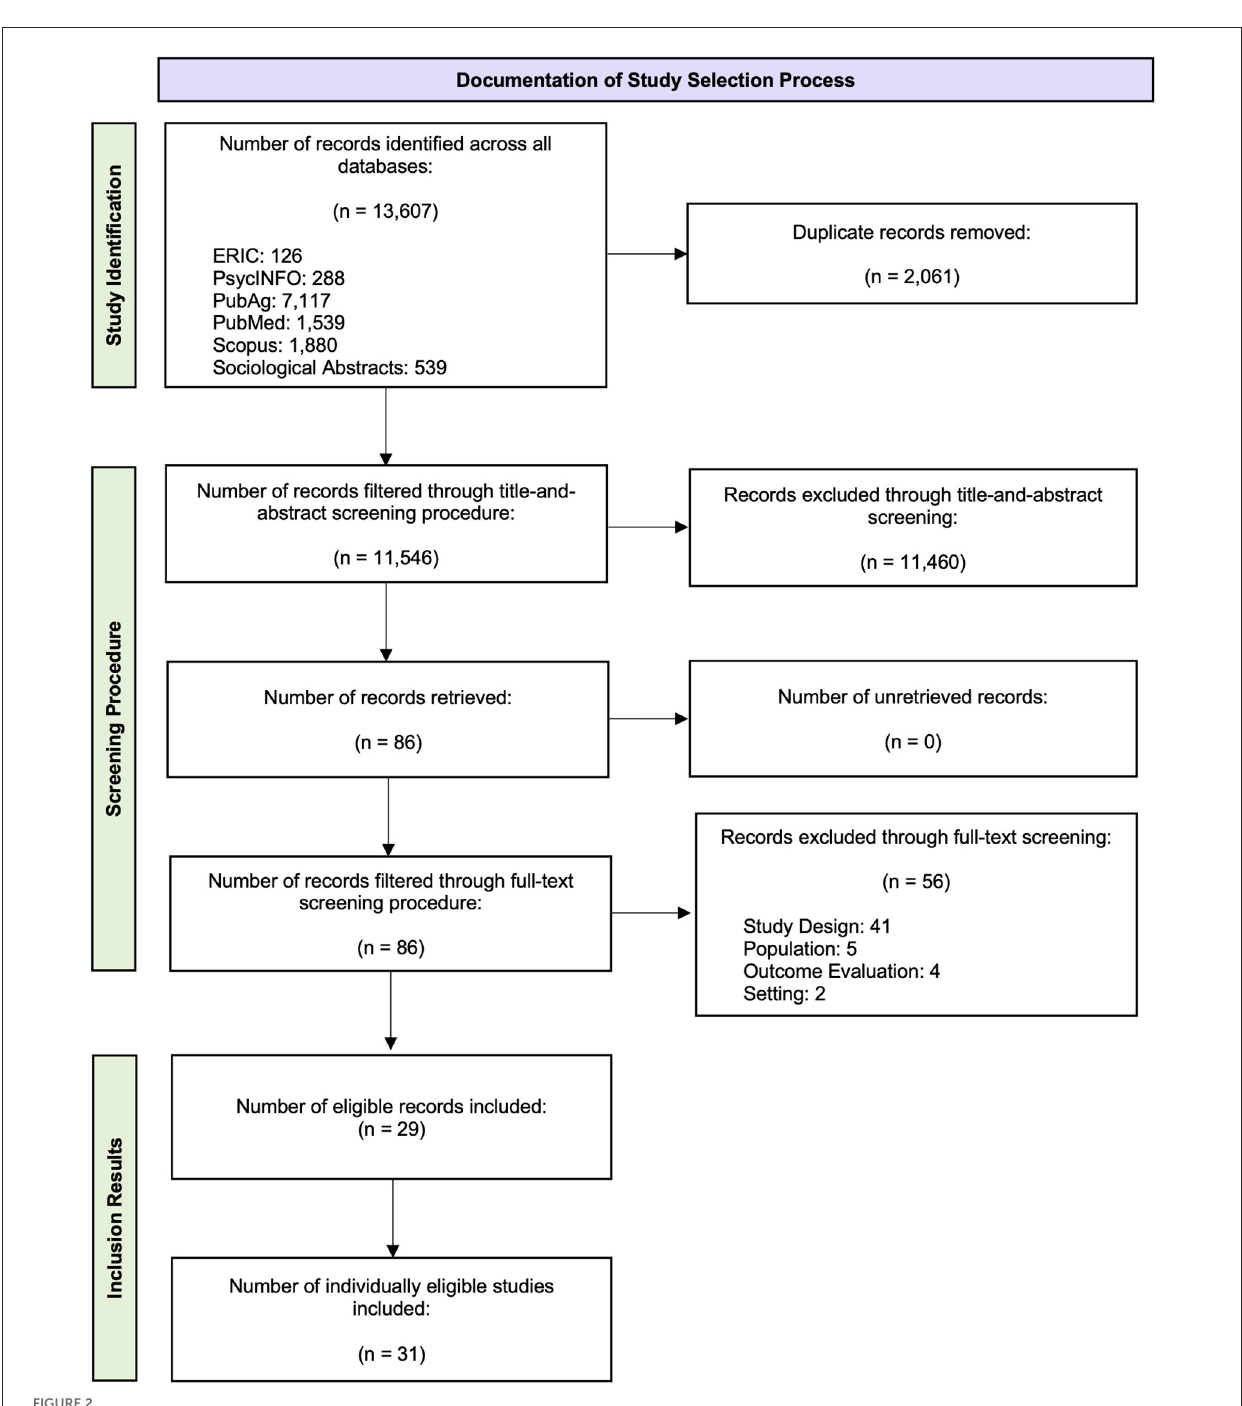
FIGURE2 Adapted PRISMA 2020 flow diagram outlining the stepwise results of our study selection process. There were seven instances where a third independent reviewer was needed to settle arising disputes in voting. Each of these instances emerged during the initial stage of title-and-abstract screening and were ultimately resolved via group